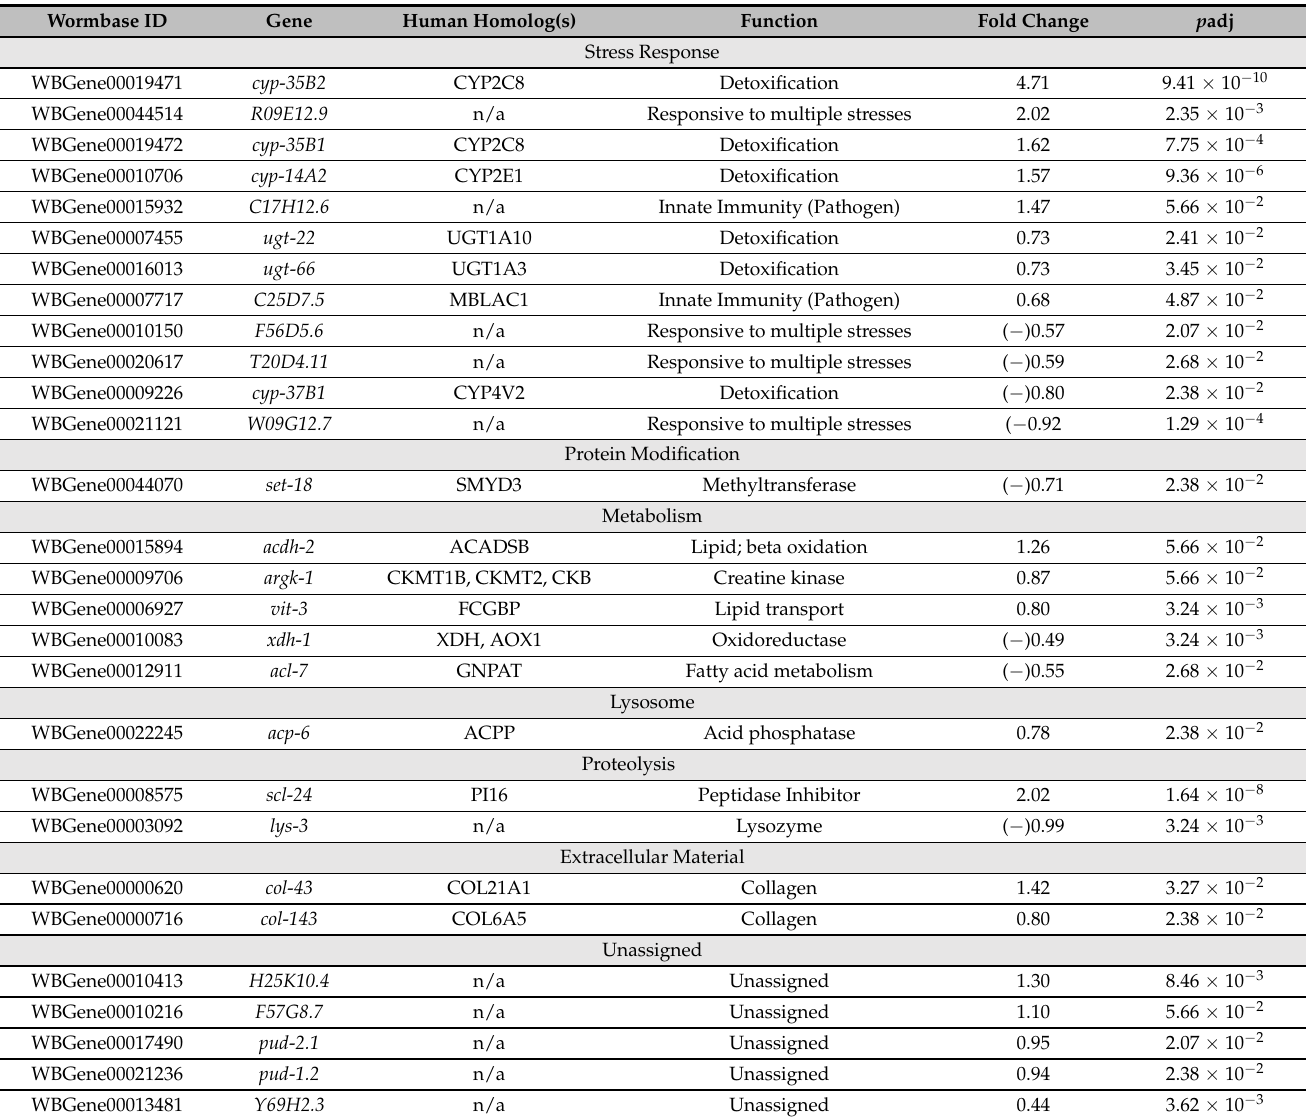
Table 2. Functional Annotation of Day 7